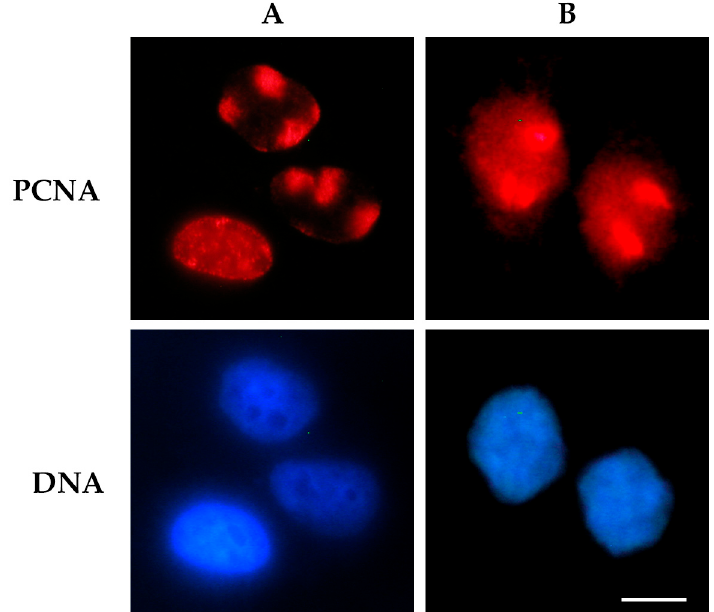
Figure 2. Detection of proliferating cell nuclear antigen (PCNA) protein bound to DNA after UV radiation-induced DNA damage. Cells were exposed to UV radiation (30 J/m 2 ) through a 3 µm micropore polycarbonate filter to produce local DNA damage. In ( A ), the cells were processed for an in situ extraction to visualize only PCNA bound to DNA at local damage sites (red spots), or at sites of DNA replication (diffuse pattern) [24]. In ( B ), cells were directly fixed after UV irradiation to detect the total nuclear PCNA. In both panels, PCNA protein (red fluorescence) was detected by immunofluorescence staining with PC10 monoclonal antibody and an Alexa 594-conjugated secondary antibody. DNA was stained with Hoechst 33258 dye. Scale bar = 10 µm.